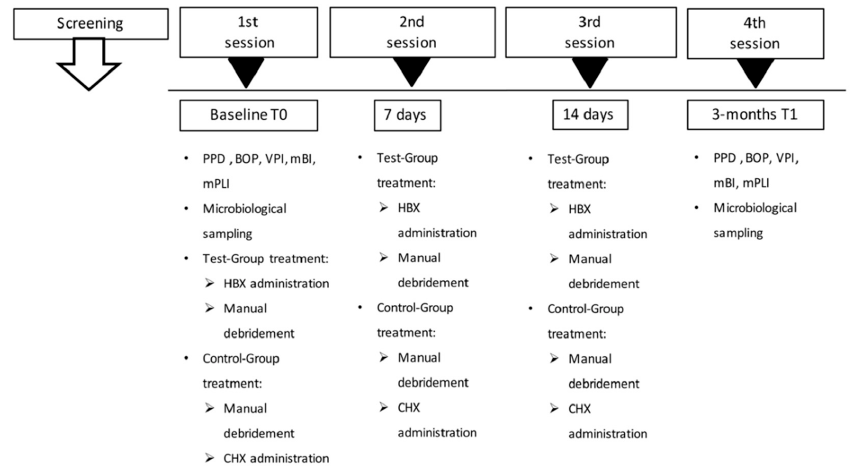
Figure 3. The study flow-chart.